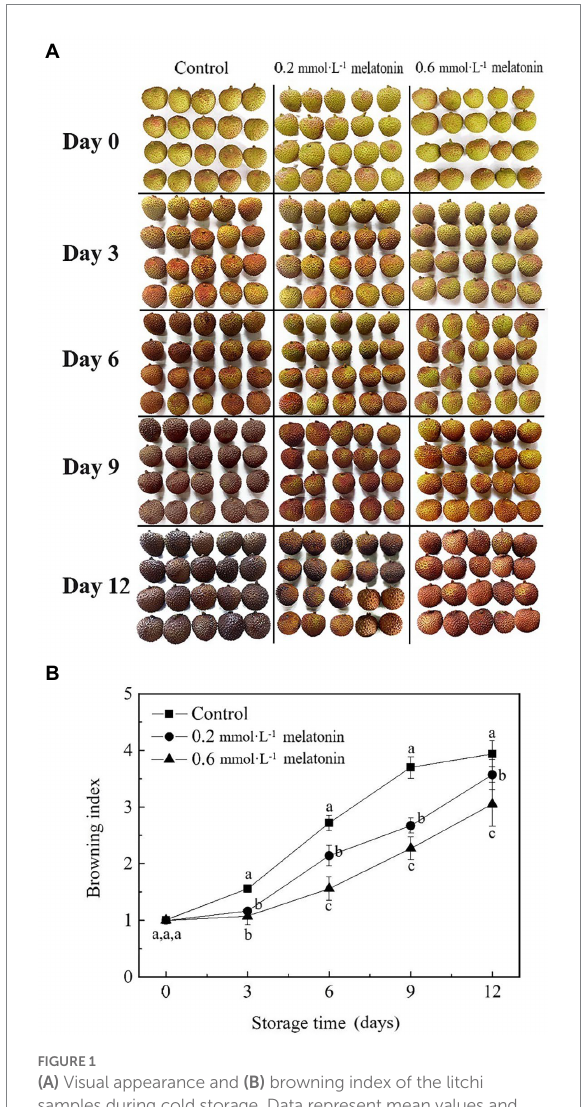
FIGURE 1 (A) Visual appearance and (B) browning index of the litchi samples during cold storage. Data represent mean values and standard errors of three replicates. Different lowercase letters (a–c) indicate significant differences between different groups ( p <